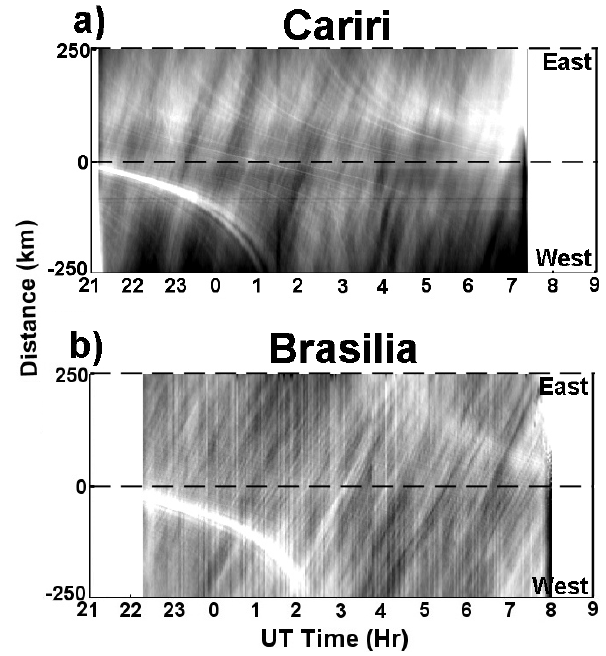
Fig. 5. Unwarped image of Fig. 2b mapped on a 500 × 500km linear grid. The white lines delineate the rows and columns used to create the west-east and north-south Keograms, respectively. Fig. 6. Example west-east Keograms for (a) Cariri and (b) Brasilia obtained on the night of 1–2 October. The medium-scale gravity waves appear as coherent, tilted